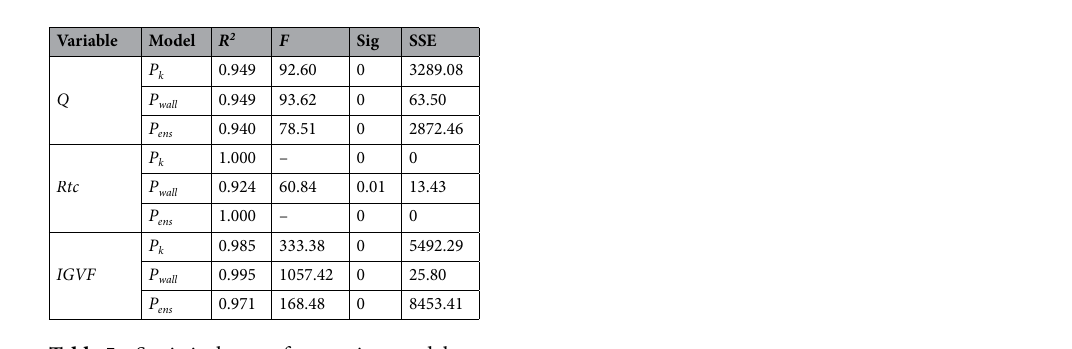
Table 5. Statistical tests of regression